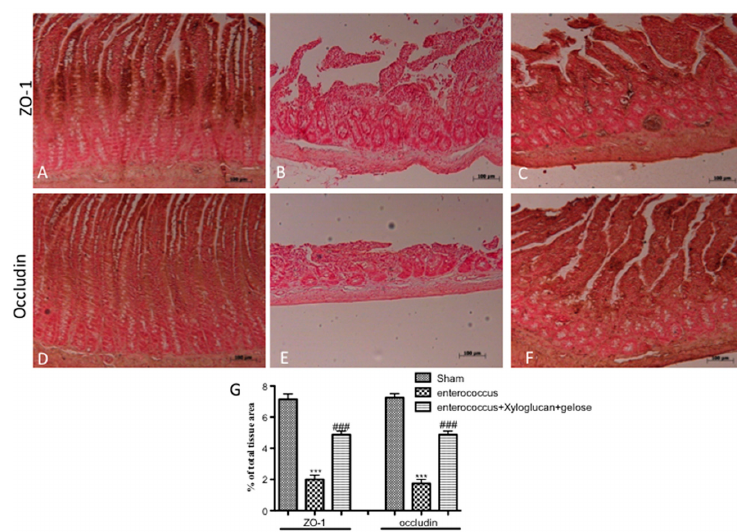
Figure 5. Immunostaining for ZO-1 and occludin expression in sham mice (( A ) and ( D ) respectively). Positive staining for ZO-1 and occludin following E. hirae infection (( B ) and ( E ) respectively) and mice treated with xyloglucan + gelose (( C ) and ( F ) respectively). ( G ) Densitometric analysis. Data are representative of at least three separate experiments. Images are representative of all animals in each group. Pictures were captured at 10 × magnification (scale bar = 100 µ m). Values are means ± SEM of 10 animals for each group. Figures are representative of at least three separate experiments. (ZO-1) *** p < 0.01 vs. Sham, ### p < 0.001 vs. E. hirae ; (occludin) *** p < 0.001 vs. Sham and ### p < 0.001 vs. E.